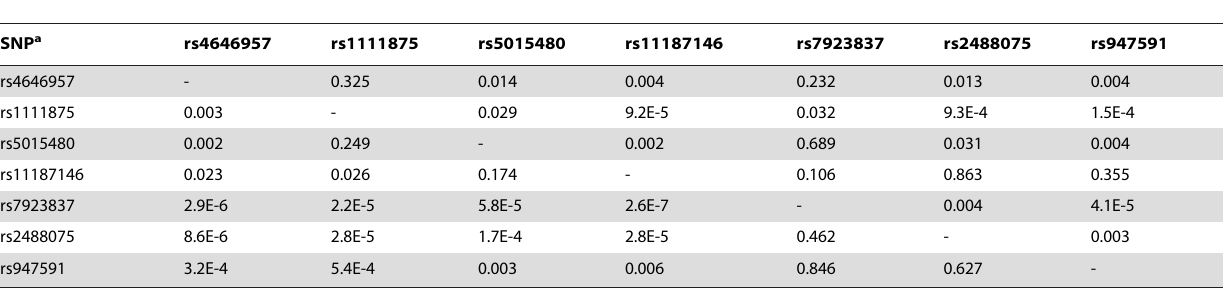
Table 4. Pairwise conditional analysis for 7 SNPs at 10q23.33 consistently associated with type 2 diabetes risks in additive genetic